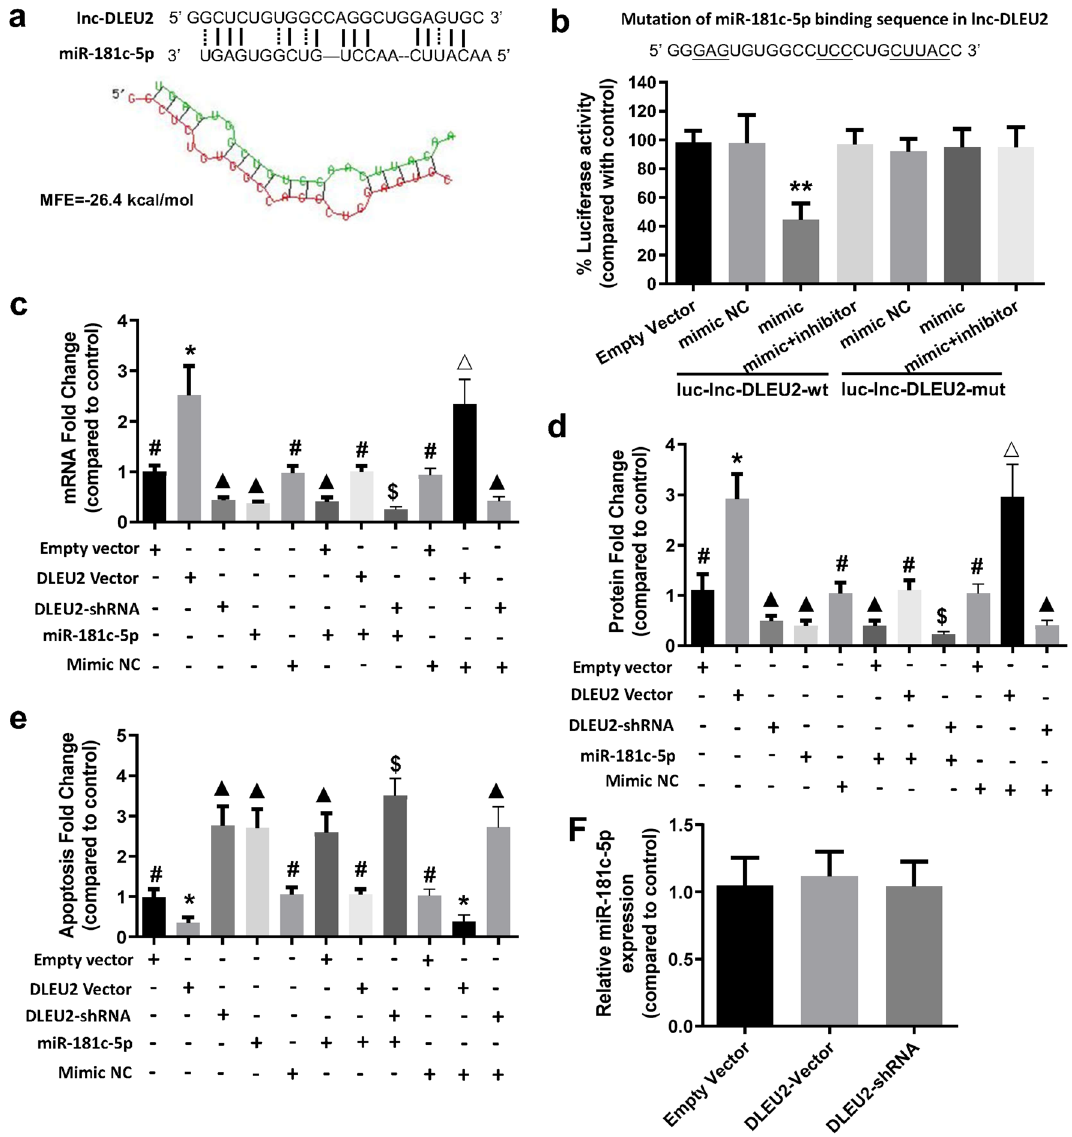
Figure 5. LncRNA-DLEU2 directly binds to miR-181c-5p and inhibited its effects on NCAPG expression and apoptosis of LMECs. ( a ) Upper panel, the predicted core binding sequence of miR-181c-5p in lnc-DLEU2 sequence. The solid line represented the standard base pairing and strong interaction; dashed line represented the non-standard base pairing and relatively weak interaction. Lower panel, the predicted secondary structure of the binding site of miR-181c-5p and lnc-DLEU2. Secondary structure was predicted using online tool RNAhybrid 24 . ( b ) Upper panel, the mutation of miR-181c-5p binding sequence in lnc-DLEU2. The underlined letters indicated the mutation bases. Lower panel, LMECs was co-transfected by no-insert empty vector, luc-lnc-DLEU2-wt vector or luc-lnc-DLEU2-mut vector along with miR-181c-5p (mimic), or mimic and inhibitor of miR-181c-5p (mimic + inhibitor), or negative control sequences (mimic NC). **: p < 0.01 compared with all other groups. All experiments were repeated five times independently. ( c , d ) The relative expression levels of NCAPG at mRNA ( c ) and protein ( d ) levels in LMECs with different treatments. #: p < 0.01 versus all other groups except for group with the same label; *: p < 0.001 versus all other groups except for DLEU2 Vector + Mimic NC group; △ : p < 0.001 versus all other groups except for DLEU2 Vector group; ▲ : p < 0.01 versus all other groups except for group with the same label; $: p < 0.01 versus all other groups. ( e ) Relative changes of apoptosis of LMECs with different treatments. The untreated LMECs were used as control. #: p < 0.01 versus all other groups except for group with the same label; * : p < 0.01 versus all other groups except for group with the same label; ▲ : p < 0.01 versus all other groups except for group with the same label; $ : p < 0.05 versus all other groups. ( f ) The relative expression levels of miR-181c-5p in LMECs with different treatments. The non- transfected LMECs were used as control in ( c – f ). Data are presented as mean ± SEM. One-way ANOVA analysis with Tukey’s post hoc test was used for statistical